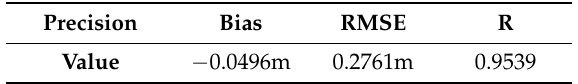
Table 3. Accuracy analysis of CYGNSS SWH estimates versus buoy